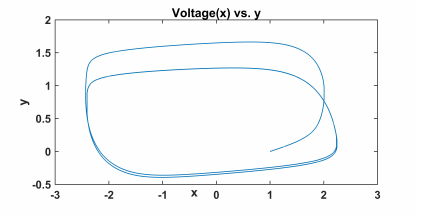
Figure 23. Responses of membrane potential with a constant external current value, I(t) = 2 sint µ A / cm 2 , a = 0.8 , b = 0.7 & c = 3